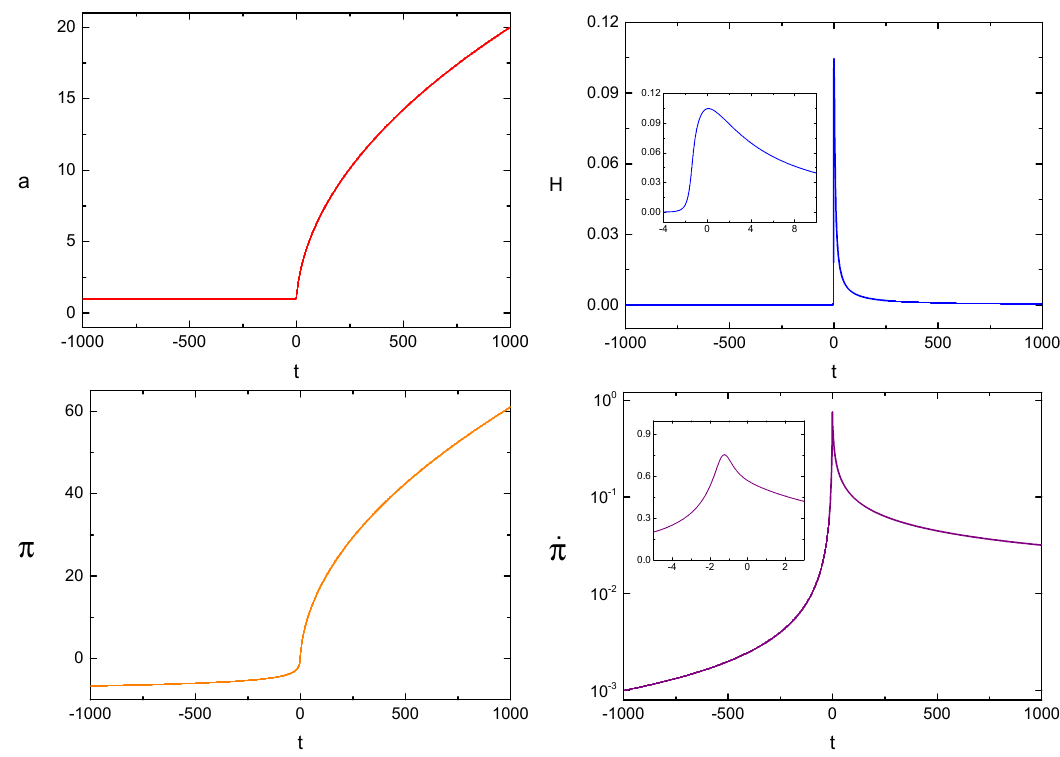
Figure 1 . Dynamics of background geometry a , H and scalar field π , ˙ π as a function of cosmic time t with the special parameter set